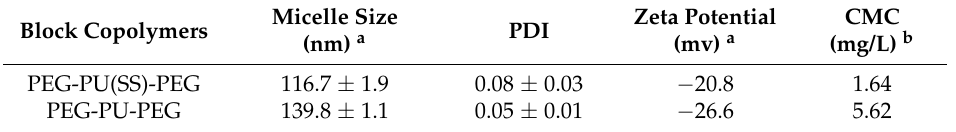
Figure 2. ( a ) Size and size distribution of PEG-PU(SS)-PEG micelles and PEG-PU-PEG micelles. ( b ) SEM image of PEG-PU(SS)-PEG micelles. ( c ) Change of size distribution of PEG-PU(SS)-PEG micelles at 37 °C, 10 mM DTT solution. ( d ) Changes in particle size of redissolved DOX-loaded PEG-PU(SS)-PEG micelles after freeze-drying. Table 2. Characterization of PEG-PU(SS)-PEG micelles and PEG-PU-PEG micelles. Block